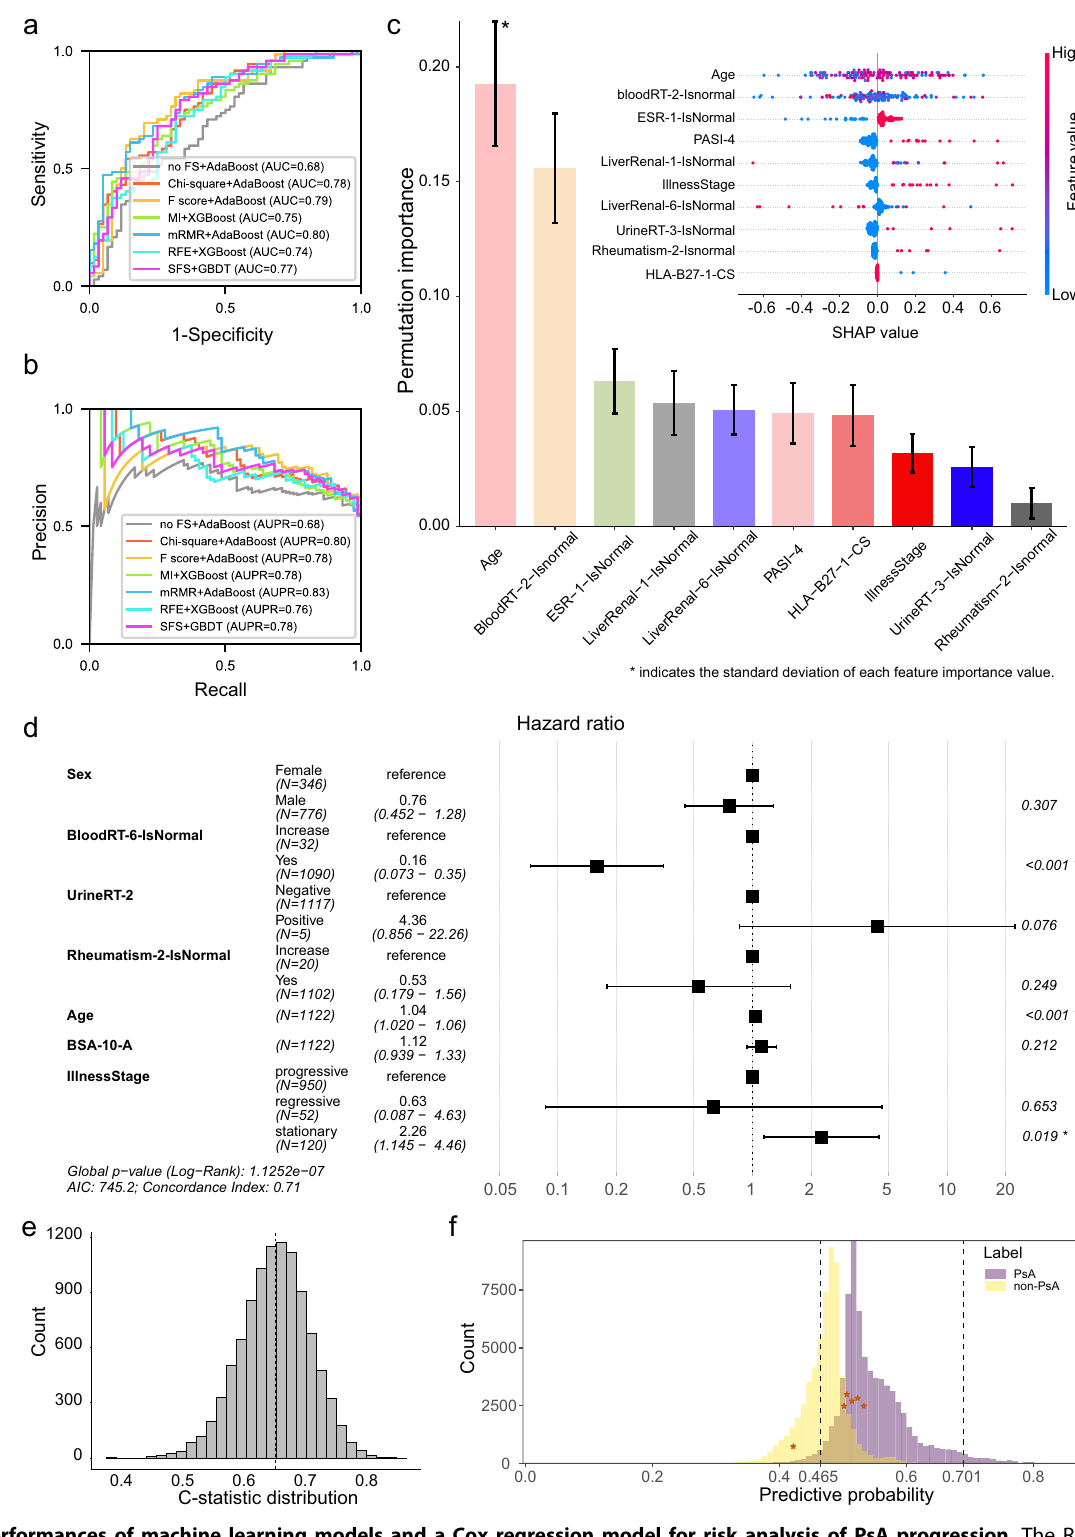
Fig. 4 Performances of machine learning models and a Cox regression model for risk analysis of PsA progression. The ROC a , and PR b curves of the various machine-learning methods under different feature selection strategies using the Jackknife (i.e., leave-one-out) validation. The feature importance analysis c of the constructed model. Each bar indicates the average feature importance value, while the black line represents the standard deviation of each feature importance value. The forest plot d and C-statistic distribution e of the best multivariate Cox regression model. The p -value is obtained by the Log-Rank Test. f The predictive probability distribution based on bootstrapping validation test and the predictive results of the new PsA patients ’ data. Each star point represents a PsA patient, and its corresponding abscissa value means its predictive probability. BloodRT blood routine test. UrineRT urine routine test. WHR waist-hip